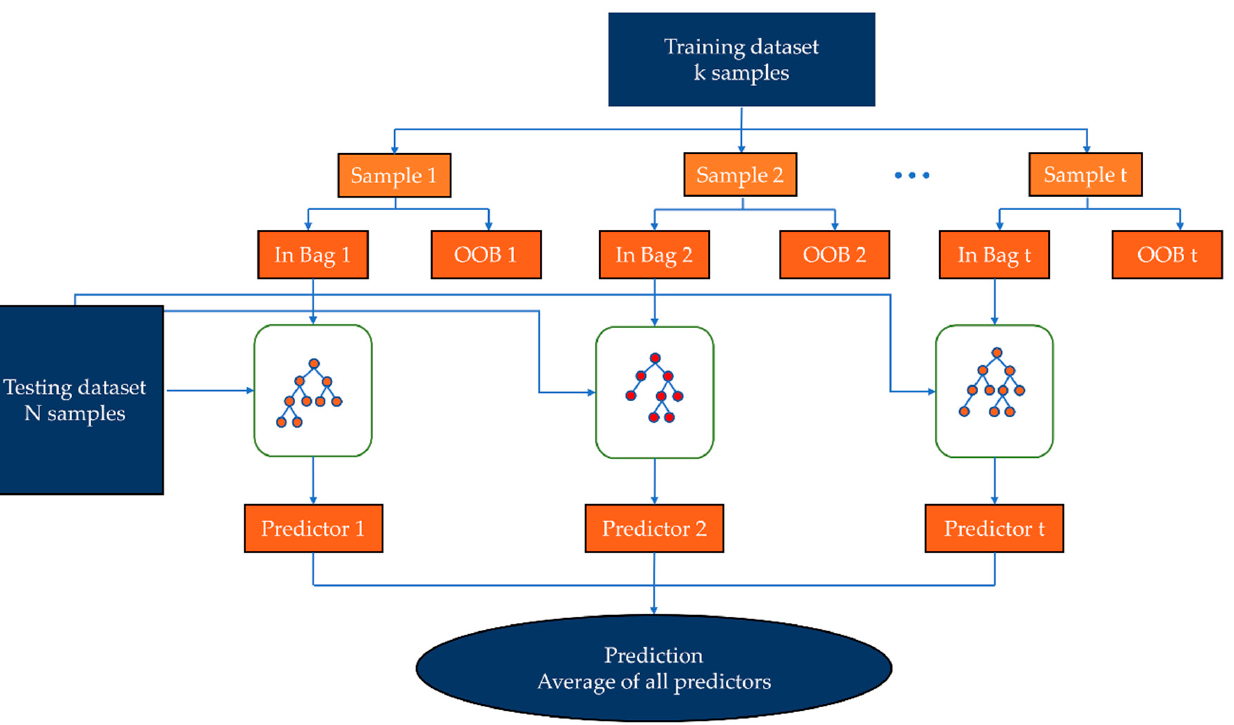
Figure 3. Framework of the random forest model (RF).